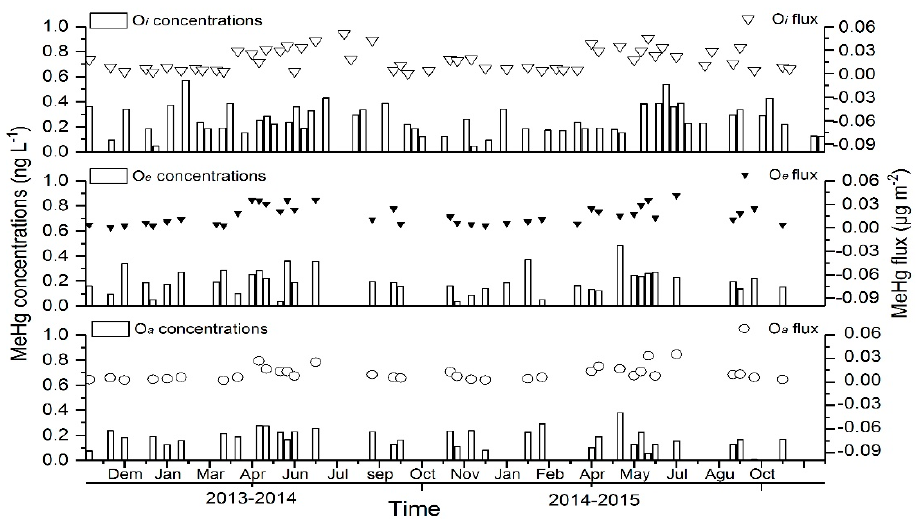
Figure 6. MeHg concentrations and fluxes in the soil percolates collected in the study forest stand from 2013 to 2015.